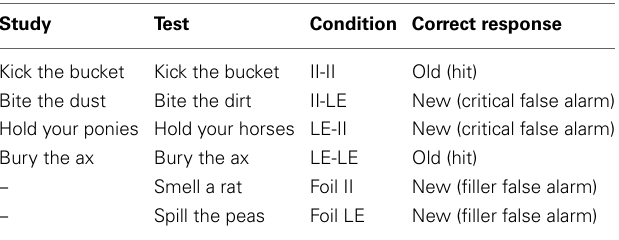
Table 2 | Sample stimuli used in the encoding and retrieval phases of the